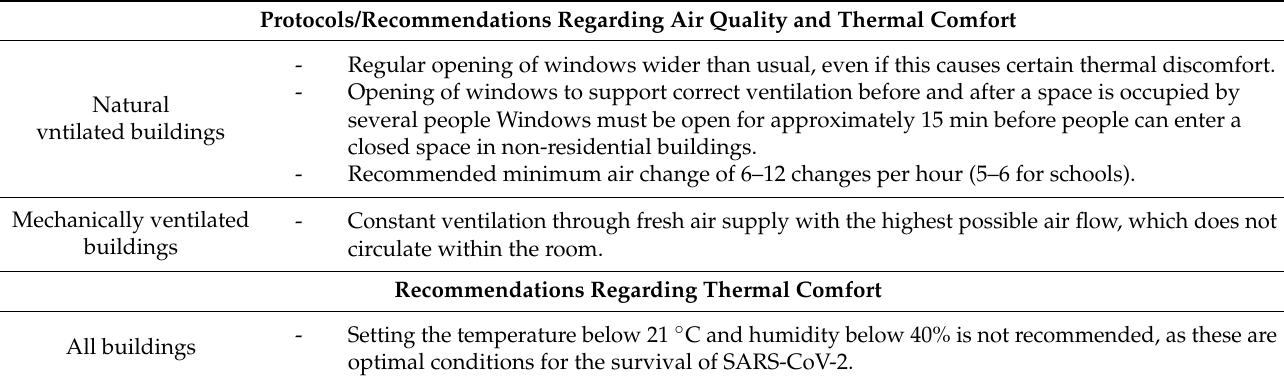
Table 1. Recommendations for kindergartens to contain the spread of SARS-CoV-2.